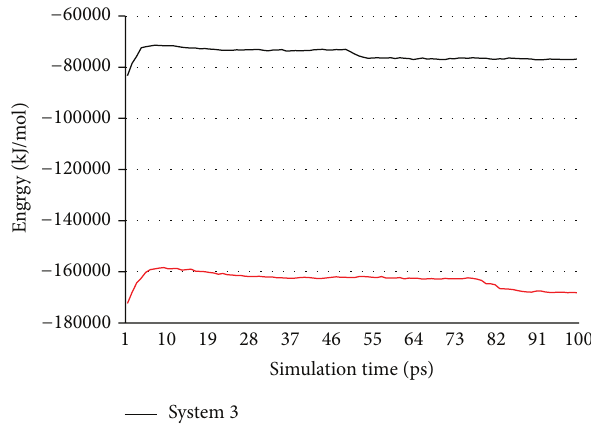
Figure 14: Curves of total energy in systems 3 and 6.